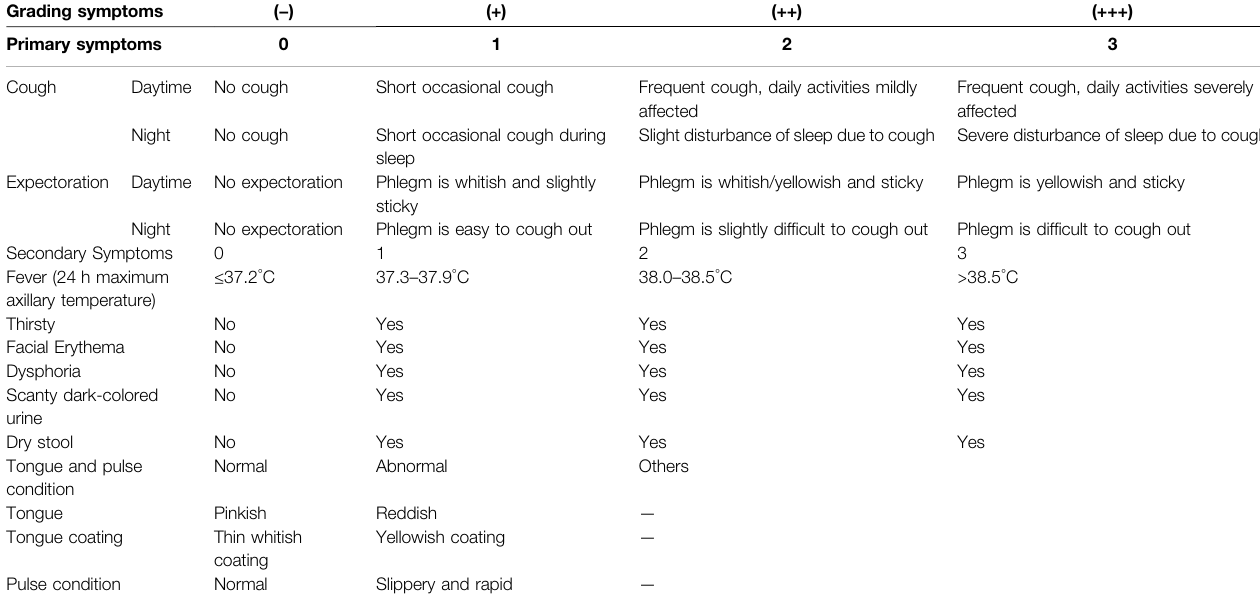
TABLE 4 | Quantitative Grading evaluation for TCM syndrome. Grading